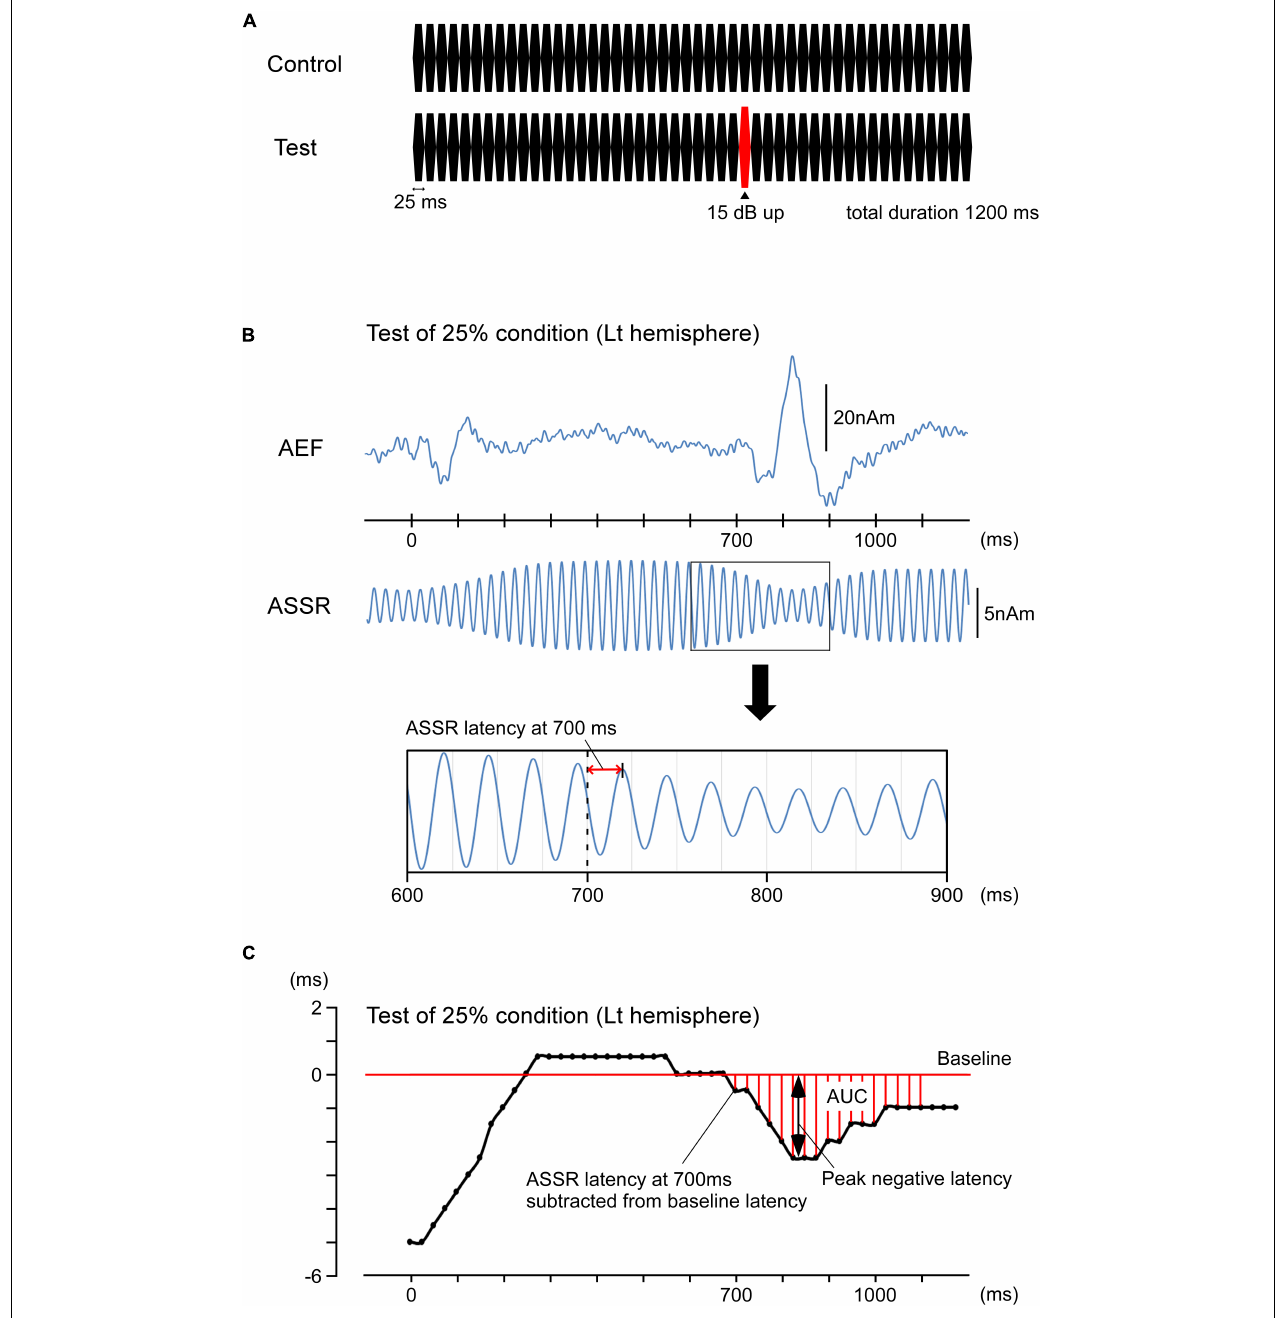
FIGURE 1 | Methods for calculating the phase shift. Data for the left hemisphere of a representative participant to the test stimulus under an oddball paradigm with the 75% control stimuli and 25% test stimuli. (A) Stimulation paradigm. There were four different probabilities of the test stimulus—0, 25, 75, and 100%. (B) The upper trace shows the source strength waveforms of auditory-evoked magnetic fields (AEFs). The lower trace shows the source strength waveforms of ASSR. The latency of ASSR at 700 ms was defined as the interval to the peak of the first upward wave after 700 ms. The ASSR latencies at 600, 625, 650, and 675 ms were similarly obtained, averaged, and used as the standard. The ASSR latencies for all sampling points were expressed as the deviation from the standard. (C) The peak latency of ASSR sine waves is plotted for each time point. The peak negative latency and area under the baseline curve (AUC) are shown in the figure.